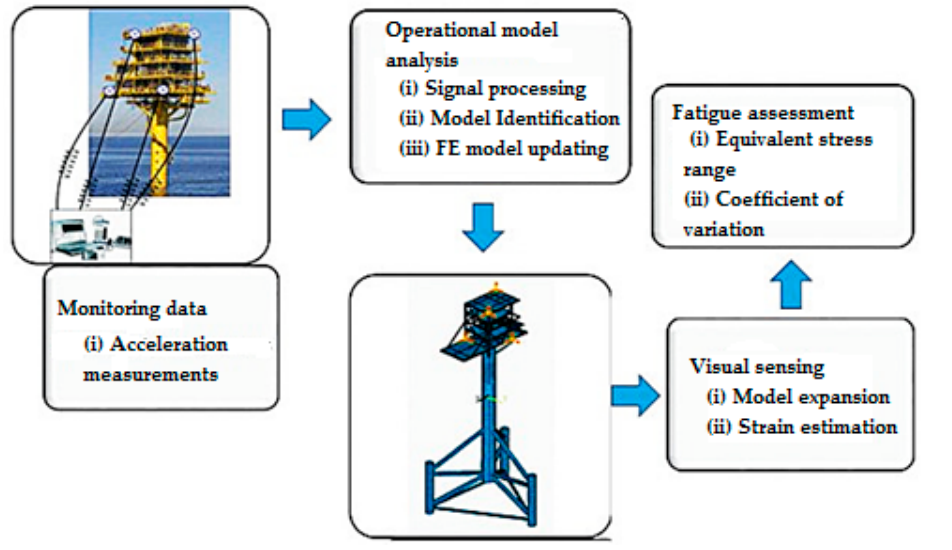
Figure 14. The methodology of fatigue analysis [76].